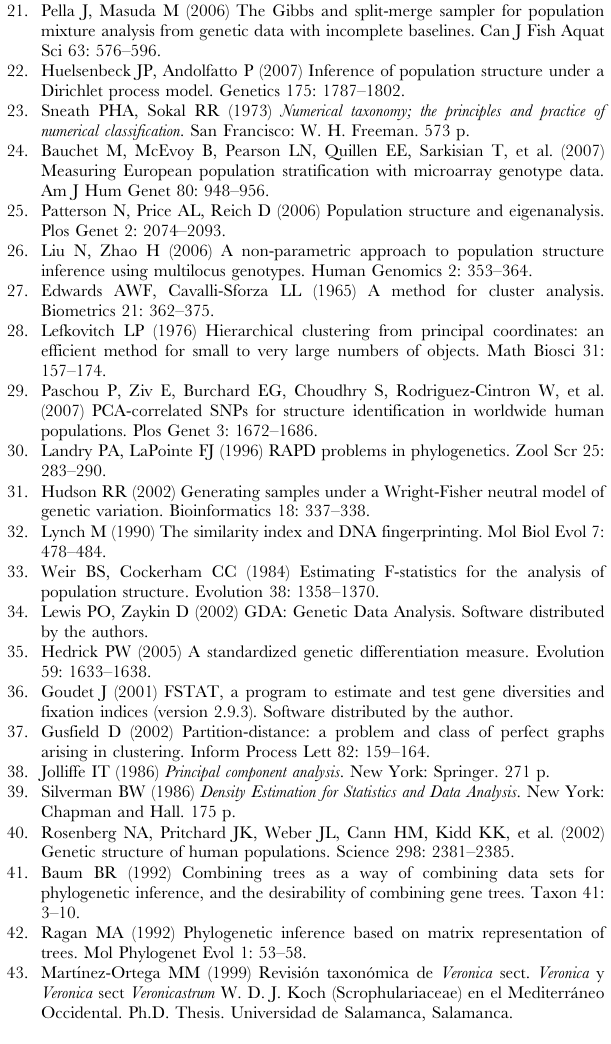
Figure S2 Hierarchical assignments from PCO-MC analysis of three additional exemplar data sets. Numbers at nodes are stability values. Asterisks indicate clusters found to be statistically significant (p , 0.05). A) Veronica spp. [46]. B) Mimulus spp. [47]. C) Pritzelago alpina [52]. Table S1 Animations demonstrating change in the density landscape, and thus the assignment, with changing R